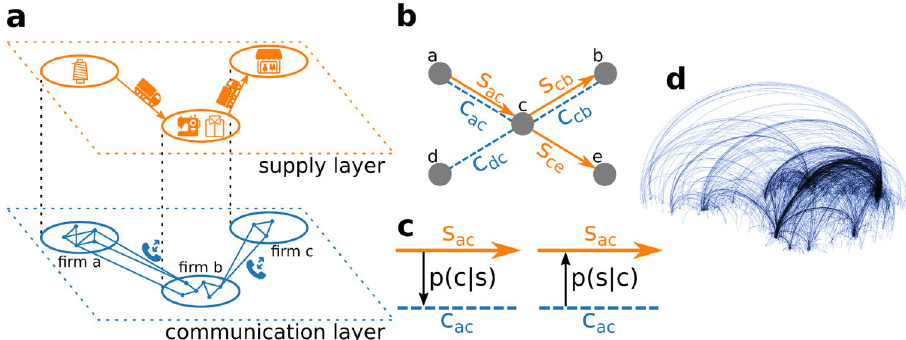
Figure 1. ( a ) Schematic view of the inter-firm multilayer network with a communication layer (blue) of phone calls between groups of devices that are associated to firms and the supply layer that captures the actual flow of goods (orange). ( b ) Section of the multilayer network where communication links, c ij , exist if at least one phone call between firms i and j takes place and supply links, s ij , exist if goods flow from i to j . ( c ) Conditional probabilities between supply links and communication links are defined as the probabilities to find a supply link, conditional on a communication link being present, p ( s | c ) and vice versa for p ( c | s ). ( d ) The inter-firm communication network as provided by a mobile phone company. Arcs link firms that have an average call duration of more than 150 s/d. Firms are slightly dislocated randomly, enough to ensure the anonymity of